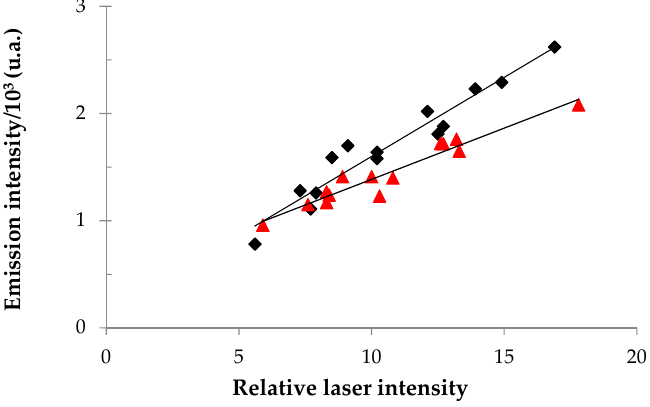
Figure 3. Plots of singlet oxygen emission intensity at 1270 nm as a function of relative laser intensity, for 2-TQP (red) and for 1 H -phenalen-1-one (black). Measurements were carried out in tetrahydrofuran solutions. Linear regressions gave the following equations: y = 9.55 ˆ 10 ´ 5 x + 4.30 ˆ 10 ´ 4 ( R 2 = 0.931), for 2-TQP, and y = 1.47 ˆ 10 ´ 4 x + 1.25 ˆ 10 ´ 4 ( R 2 = 0.933), for 1 H